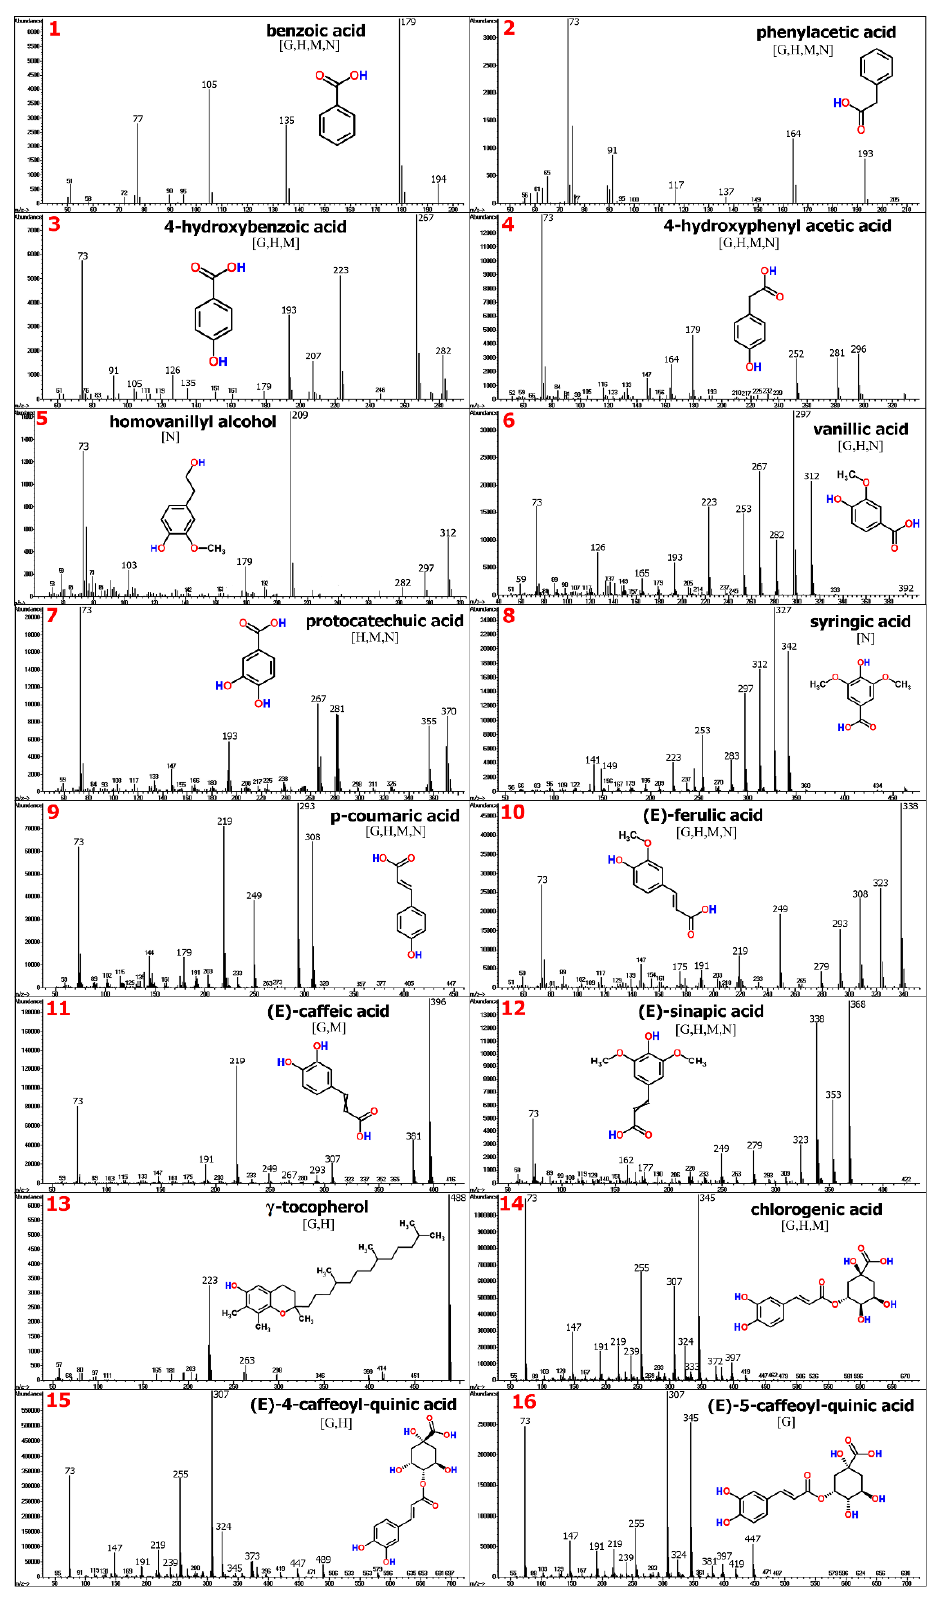
Figure 11. The MS spectra of corresponding monocyclic/polycyclic TMS metabolites (see Figure 10) indicated by nos. 1 to 16 , are depicted in the figures above. MS spectra can be found in the Golm Metabolome Database [G], Human Metabolome Database [H], MassBank [M], and/or NIST Chemistry WebBook